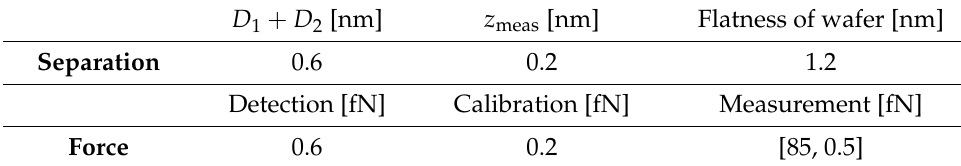
Table 1. Systematic errors in the separation and determination of the measured force. The errors in b (4 µ m) and α (0.8 nrad) do not contribute to the overall error of separation. The listed error in D 1 + D 2 is obtained from the electrostatic calibration. The error reported in z meas is larger than the local measured error of 0.2 nm due to the fact that the rotating sample has measured height difference of 1.2 nm. This is not adjusted during rotation. The force measurement error varies from 85 fN at ≈ the shortest separation to 0.5 fN at z (cid:62) 1 µ m. All errors are at the 95% confidence level. D 1 + D 2 [nm] z meas [nm]